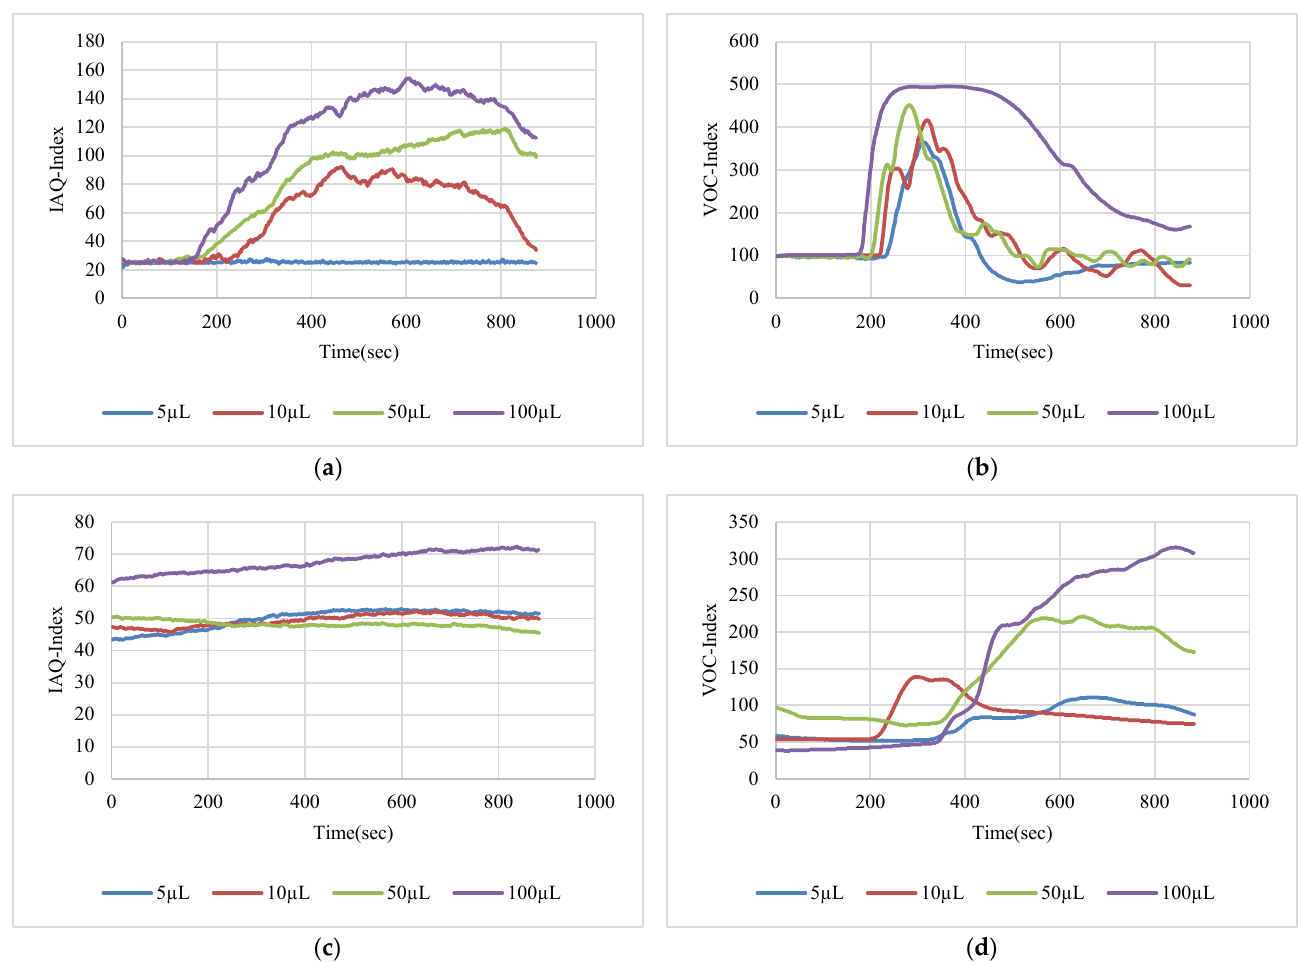
Figure 20. Test results for toluene: ( a ) BME688 40 cm, ( b ) SGP41 40 cm, ( c ) BME688 100 cm, ( d ) SGP41 100 cm.